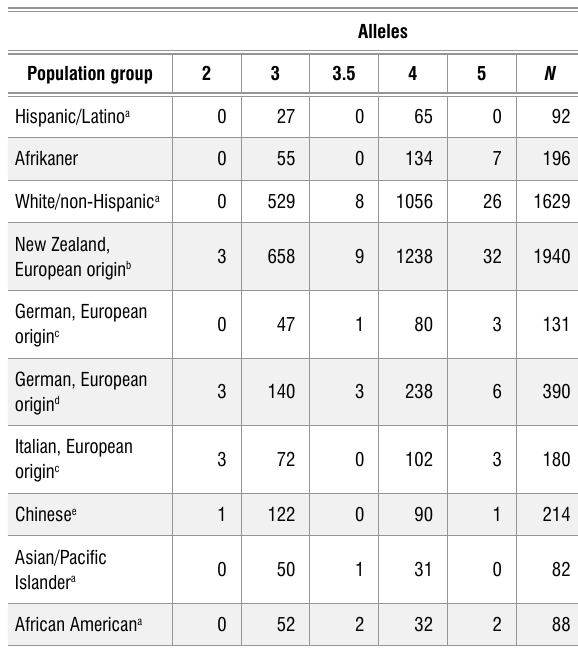
The observed number of the MAOA alleles in the Afrikaner population and in nine other populations